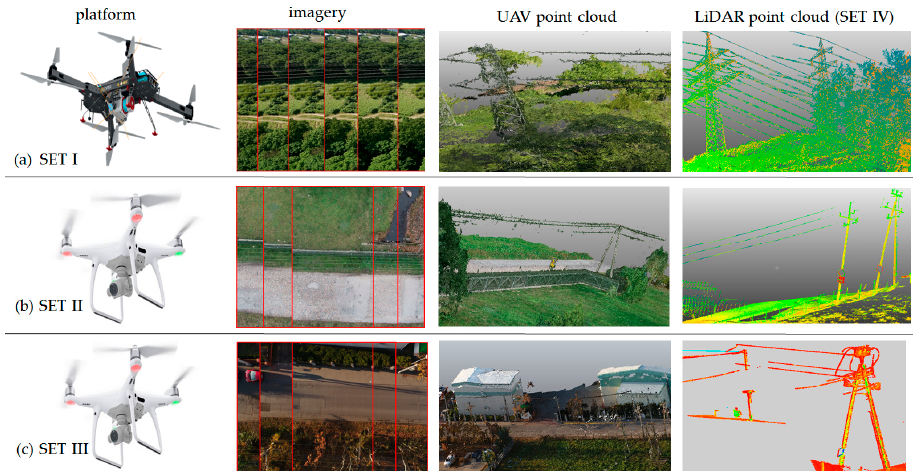
Figure 2. The view for the three data sets: ( a ) forest area and high-voltage power lines: platform, imagery, point clouds (image), point clouds ultra-light light detection and ranging (LiDAR); ( b ) rural area and mean-voltage power lines: platform, imagery, point clouds (image), point clouds (TLS); ( c ) urban area and low-voltage power lines: platform, imagery, point clouds (image), point clouds (TLS).